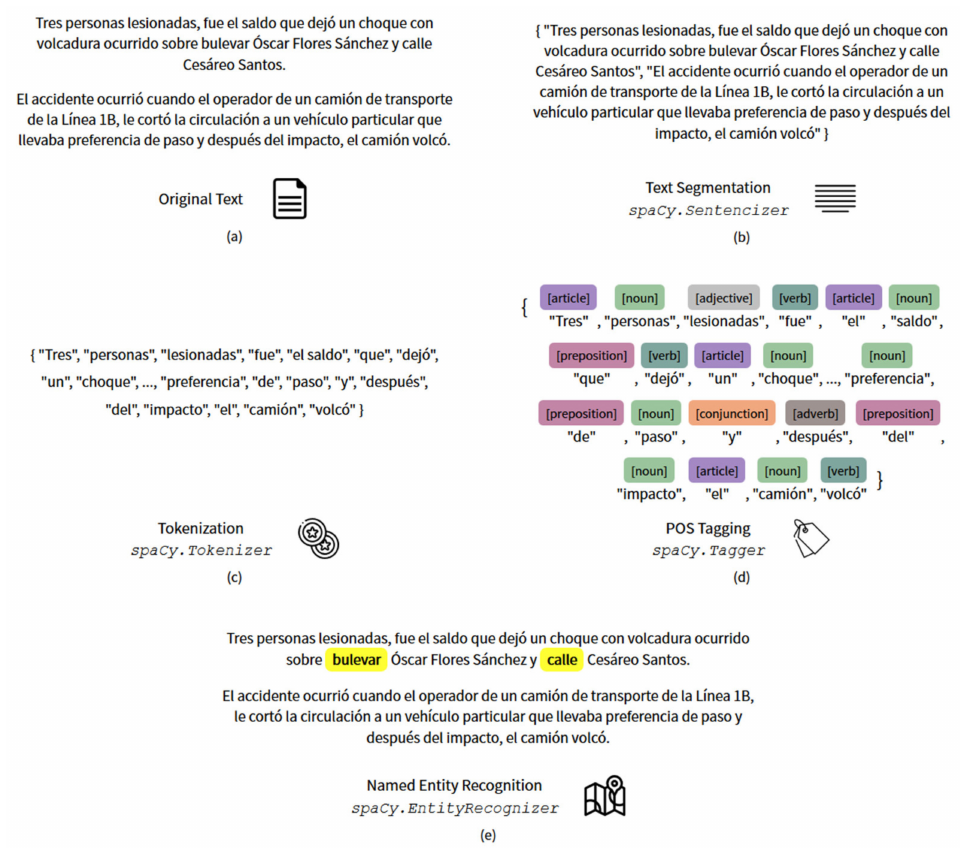
Figure A1. Processing for the Information Extraction process: ( a ) Original Text; ( b ) Text Segmentation; ( c ) Tokenization; ( d ) POS Tagging; and, ( e ) Named Entity